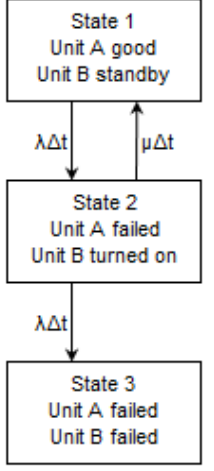
Fig. 4. State transition diagram for standby